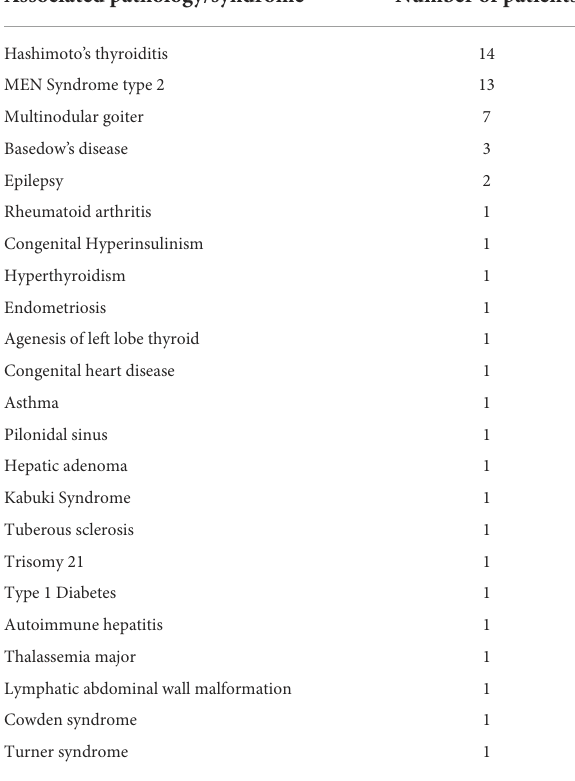
TABLE 3 List of associated pathologies and